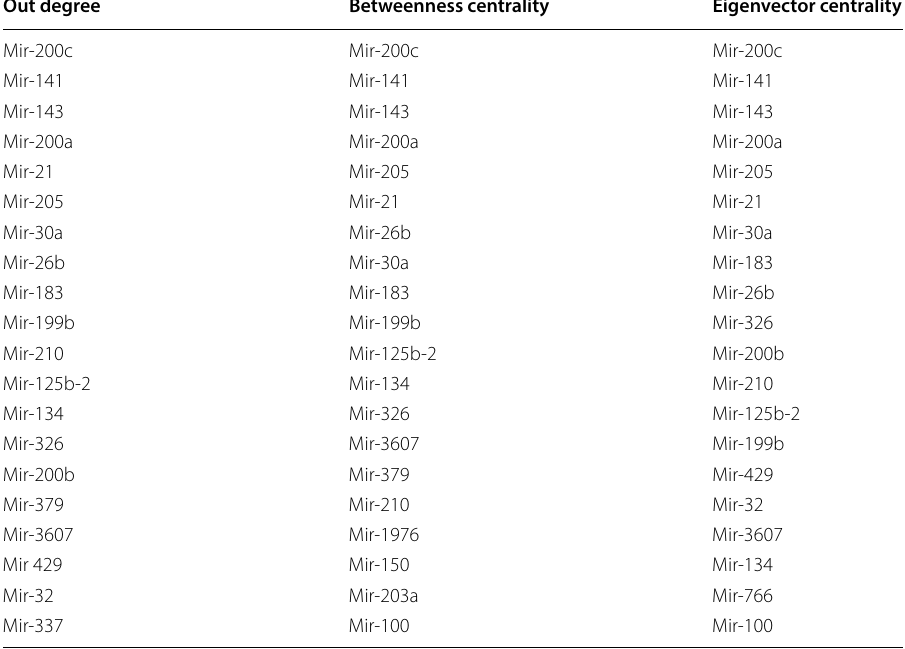
Table 2 The top 20 genes discovered from the hybrid method in terms of: out degree, betweenness centrality, and eigenvector centrality. All of these genes have been linked to breast cancer by previous